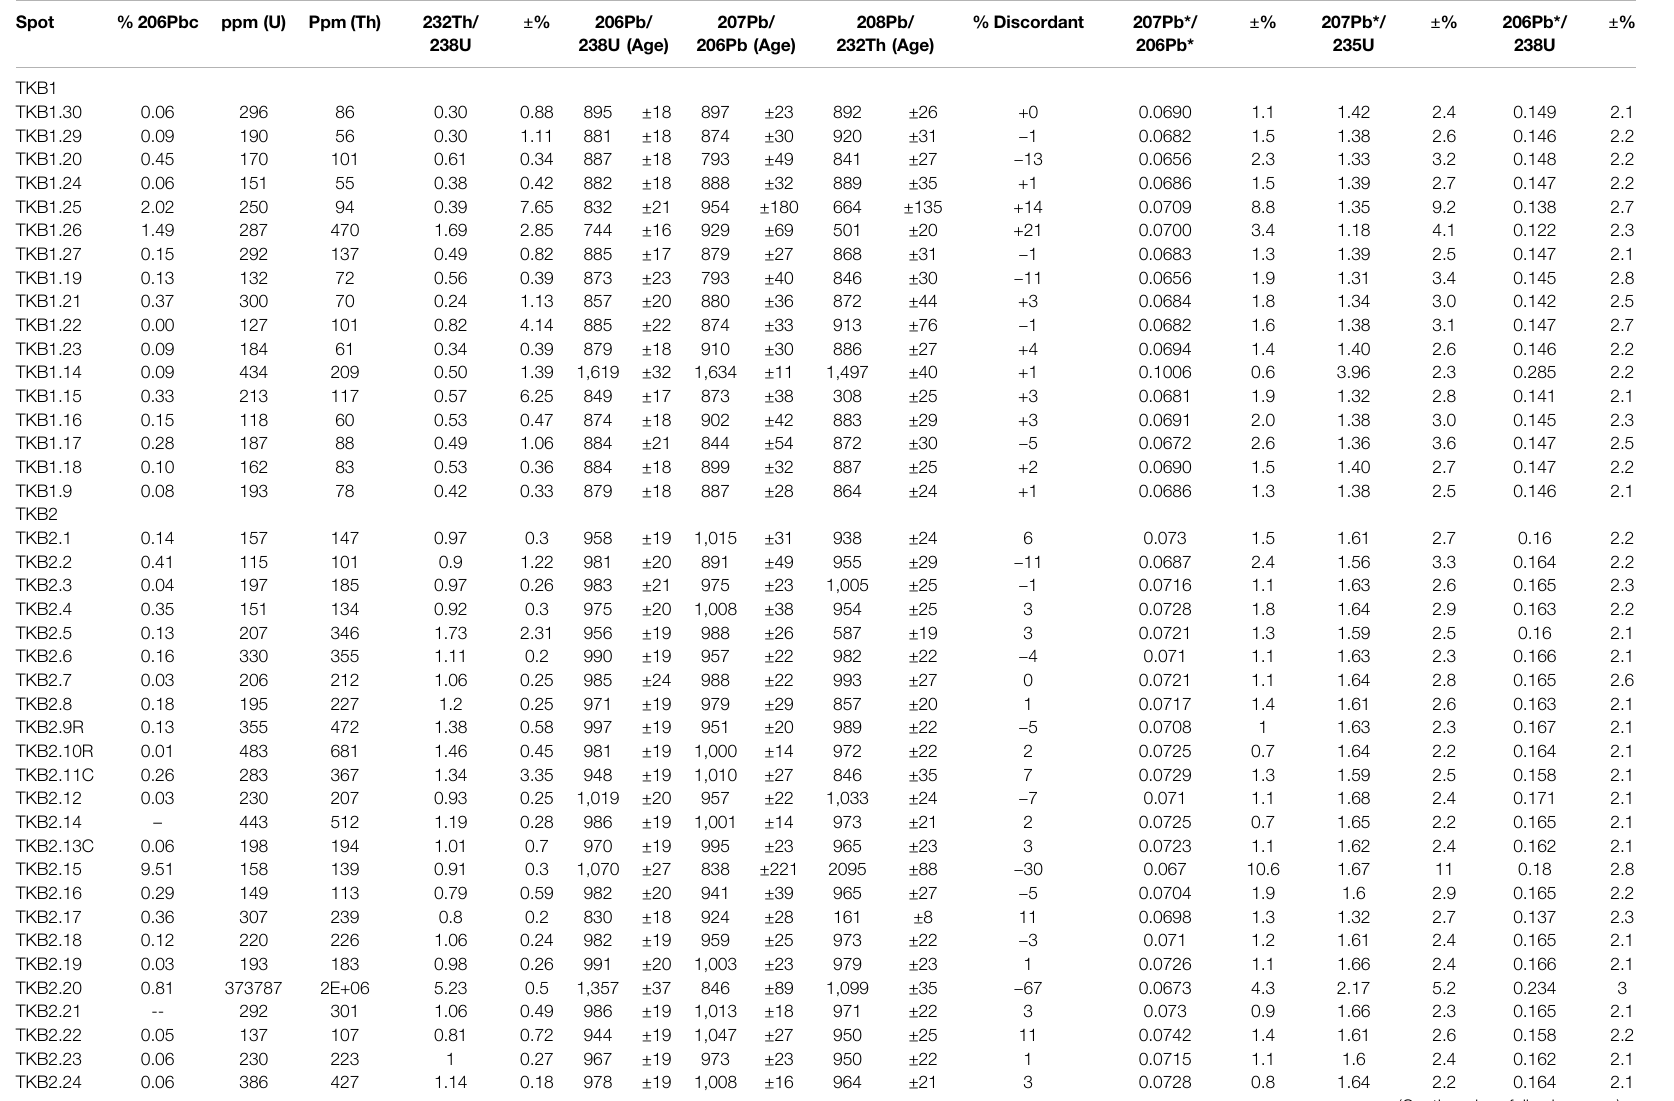
TABLE 3 | Zircon U-Pb SHRIMP data (2 σ error of the mean of 0.94%) samples TKB-1 (26,015 ′ 50 ’’ /74,013 ′ 06 ″ ), TKB-2 (26,010 ′ 36 ’’ /74,017 ′ 30 ″ ), TKB-3 (26,012 ′ 24 ’’ /74,018 ′ 15 ″ ), and TKB-4 (26,013 ′ 36 ’’ /74,019 ′ 48 ″ ).